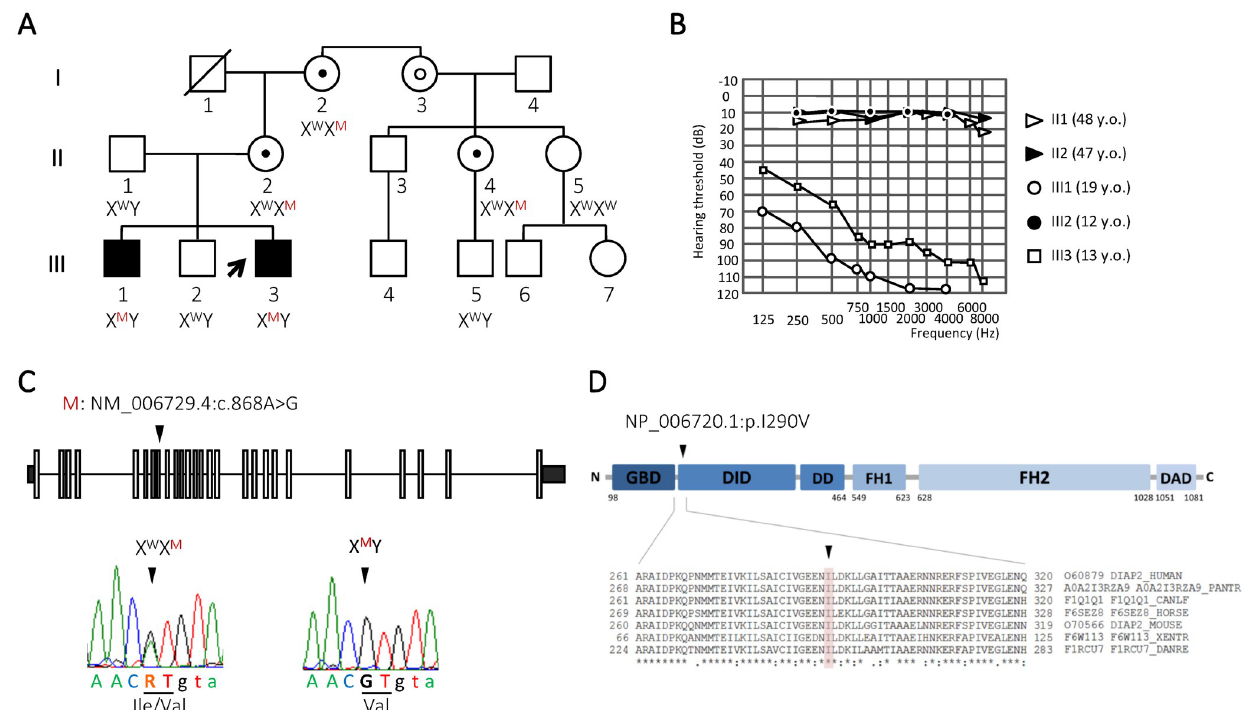
Fig 1. Identification of a missense variant in the candidate DIAPH2 gene. ( A ) Pedigree of an Italian family with nonsyndromic hearing loss, showing the segregation of the DIAPH2 variant (NM_006729.4:c.868A > G) within the family. The genotypes of available individuals are indicated below the corresponding symbol and the proband is indicated by a black arrow. W: wild-type allele (A), M: mutant allele (G). � : obligate carrier, ● : carrier of the variant confirmed by Sanger sequencing. ( B ) Pure-tone air-conduction thresholds. For each subject the threshold average for the right and left ear and the age at audiometric evaluation is shown. The two affected siblings III1 and III3 are indicated by empty circles and squares, respectively. Their brother (III2, black circles), mother (II2, black triangles), and father (II1, empty triangles) show normal hearing. ( C ) Schematic representation of DIAPH2 gene, where exons are indicated by rectangles and introns by black lines. Electropherograms showing the sequence surrounding the mutated nucleotide in the proband (right) and his mother (heterozygous carrier, left). The position of the identified variant is indicated by an arrowhead. R: A or G. Exonic nucleotides are indicated with uppercase, while intronic nucleotides are indicated with lowercase letters. ( D ) Schematic representation of DIAPH2 protein and amino acid sequence alignments of DIAPH2 orthologs in the region surrounding the mutant residue (p.I290). The position of the p.I290V is indicated by an arrowhead. Protein sequences were retrieved from UniProt, and alignments were generated with Clustal Omega. The affected amino acid residue is shadowed. Identical amino acids are marked by an asterisk, while partially conserved residues are indicated by a colon. GBD: GTPase-binding